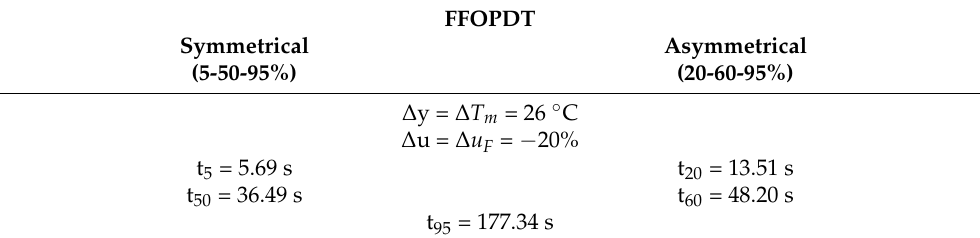
Table 9. Process information for Configuration #2 for fractional-order model identification with sets of points (5–50-95%) and (20-60-95%).